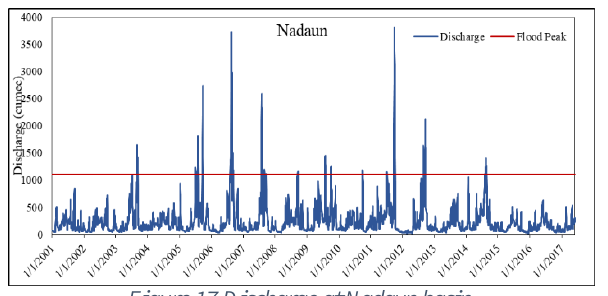
Figure 20 Simulated and observed discharge at Sujanpur